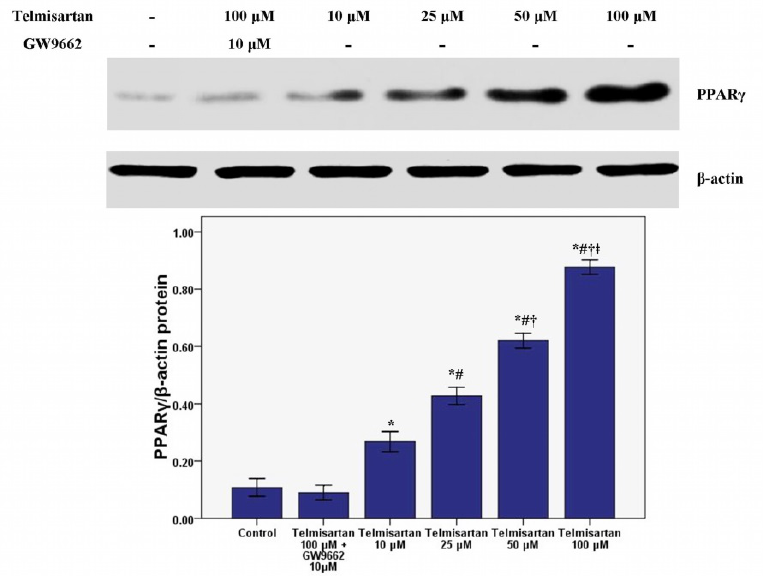
Figure 6. Telmisartan enhances the protein expression of PPAR γ in A549 cells. The protein expression of PPAR γ in A549 cells treated with 4 concentrations of telmisartan (10, 25, 50 and 100 μ M) or GW9662 (10 μ M) for 48 h were measured. Quantitative data were presented as mean ± SD ( n = 4). * p < 0.05 compared with Control. # p < 0.05 compared with 10 μ M telmisartan. † p < 0.05 compared with 25 μ M telmisartan. ǂ p < 0.05 compared with 50 μ M